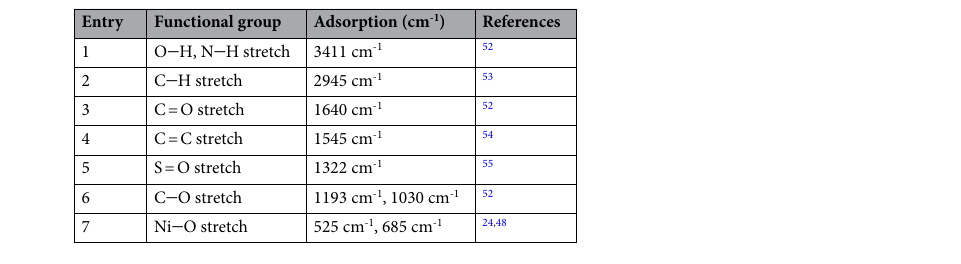
Table 1. FTIR characteristic absorption peaks of the engaged biomolecules in marine-mediated NiO